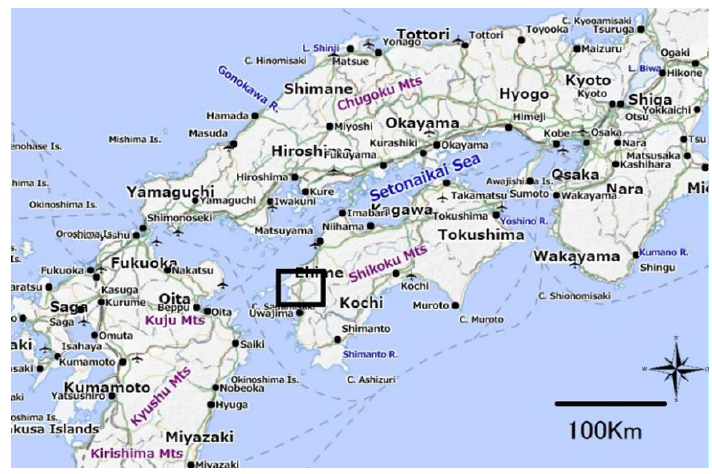
Figure 1. Location of the Hijikawa River. This map is based on a digital map published by the Geospatial Information Authority of Japan.